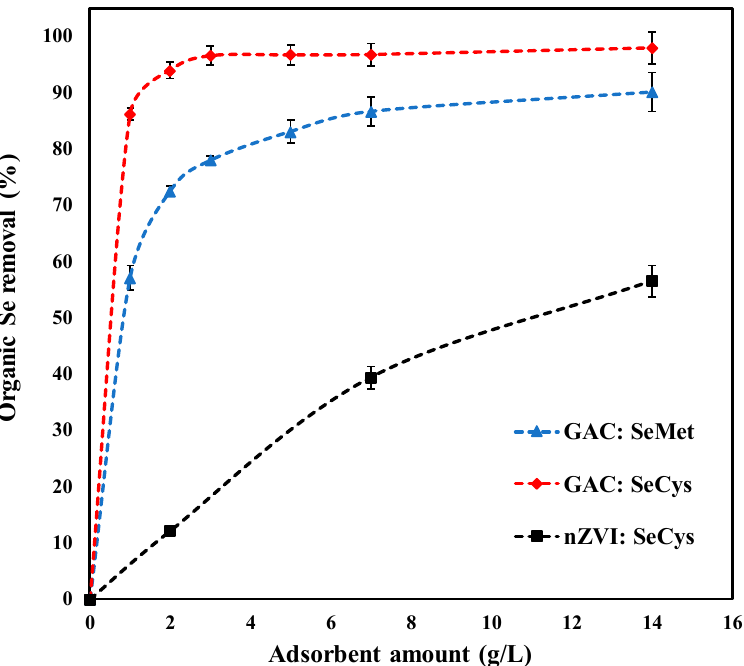
Figure 3. Effect of adsorbent dosage on organic selenium removal, by GAC and nZVI (initial concentration of 5 mg/L, pH 7.0, at 25 °C).